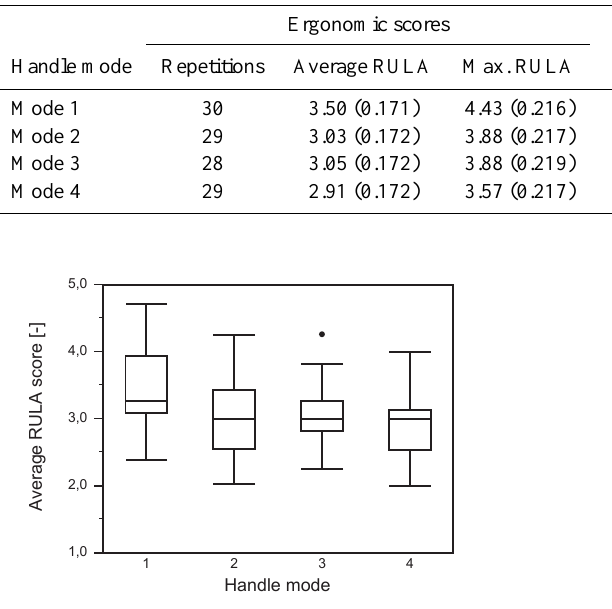
Figure 7. Box-and-whisker plot of the global performance score P for each handle mode. Sample size for each box is reported in Ta- ble 1. Outliers are represented as dots.